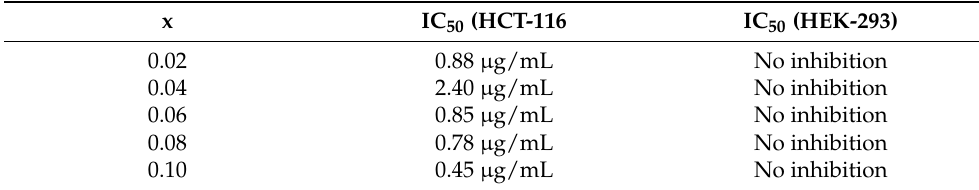
Table 1. Effect of Mn 0.5 Zn 0.5 Er x Y x Fe 2-2x O 4 NPs on cancerous cells (HCT-116) and normal cells (HEK-293).